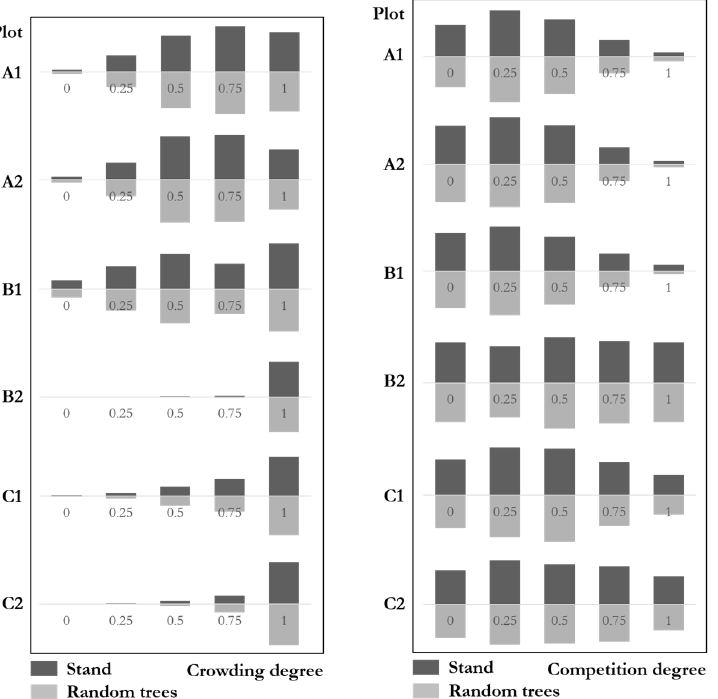
Figure 11. Crowding degree ( left ) and competition degree ( right ) distributions of stands and random trees.